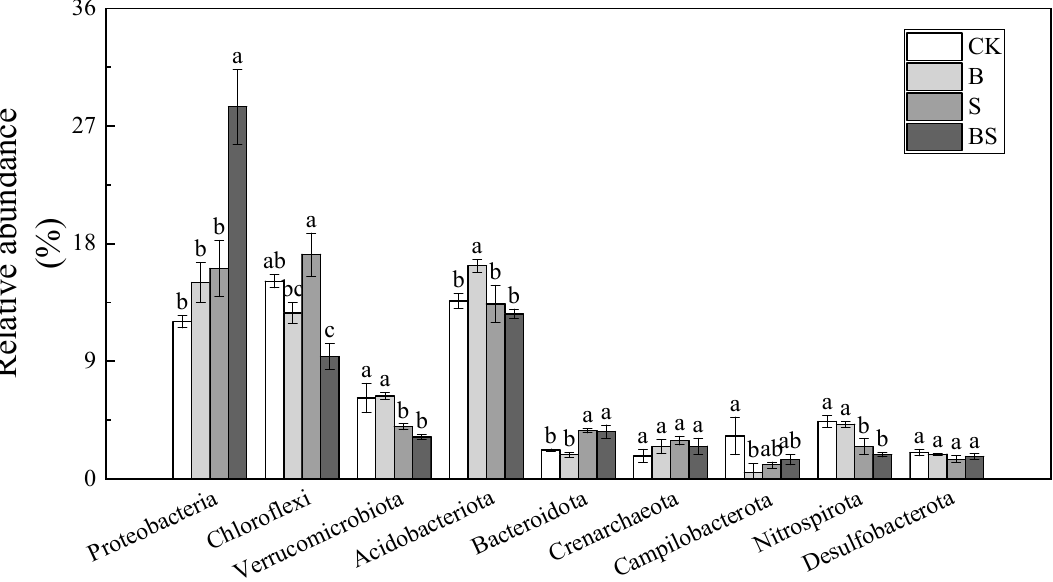
Figure 4. Relative abundances (%) of the nine most abundant phyla across four treatments. Columns with different letters are significantly different at p < 0.05. CK: organic substitution; B: organic substitution + biochar; S: CK + NaCl; BS: B + NaCl.